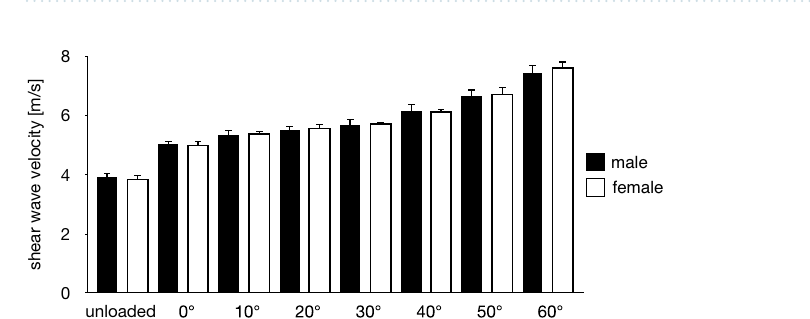
Figure 3. Representative ultrasound shear wave and B-mode images of the PA (upper and lower rows, respectively) that were obtained at 0°, 10°, 20°, 30°, 40°, 50°, and 60° of MP joint dorsiflexion under the weight- bearing condition. The PA is indicated by white triangles. The scale for the color code is provided to the left as SWV.